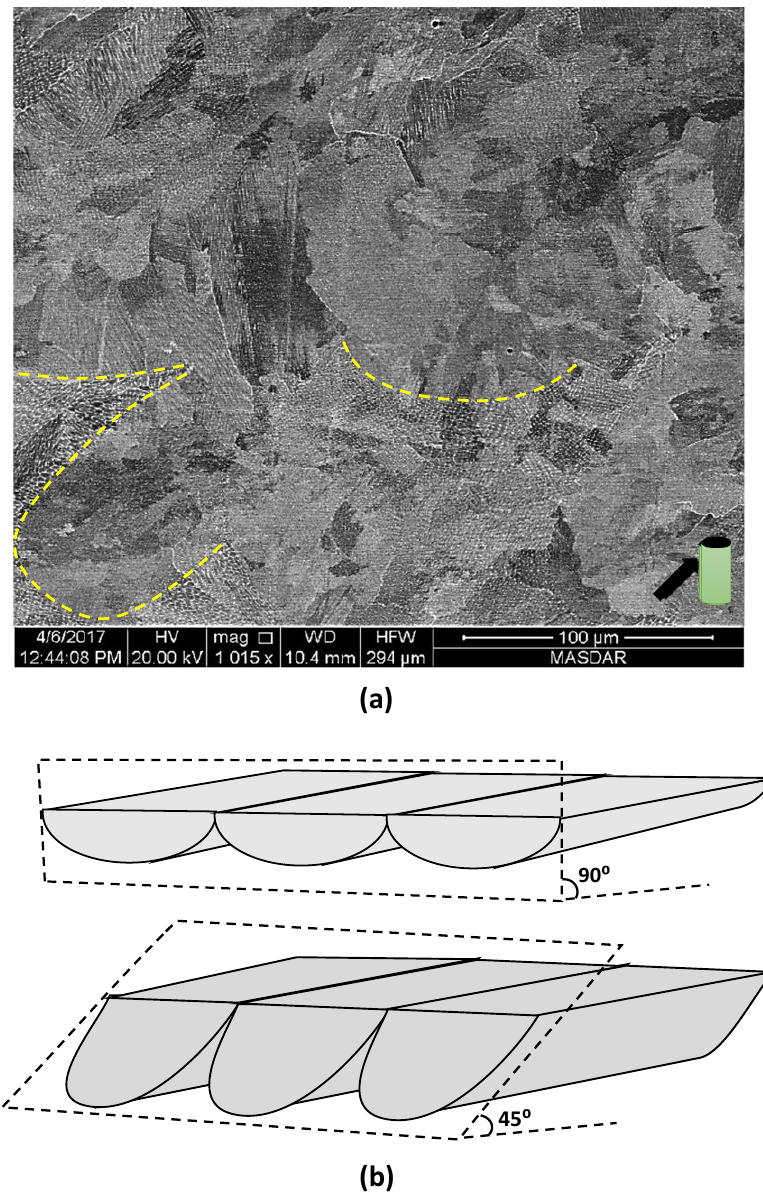
Figure 5. ( a ) Non-etched SEM image of melt pool boundaries and inter-dendritic structures of the as-printed specimen. Yellow dotted lines outline the melt pools in the image. ( b ) Illustration of melt pool distortion due to the 45° tilt (with respect to building direction) of the horizontal cross-section.